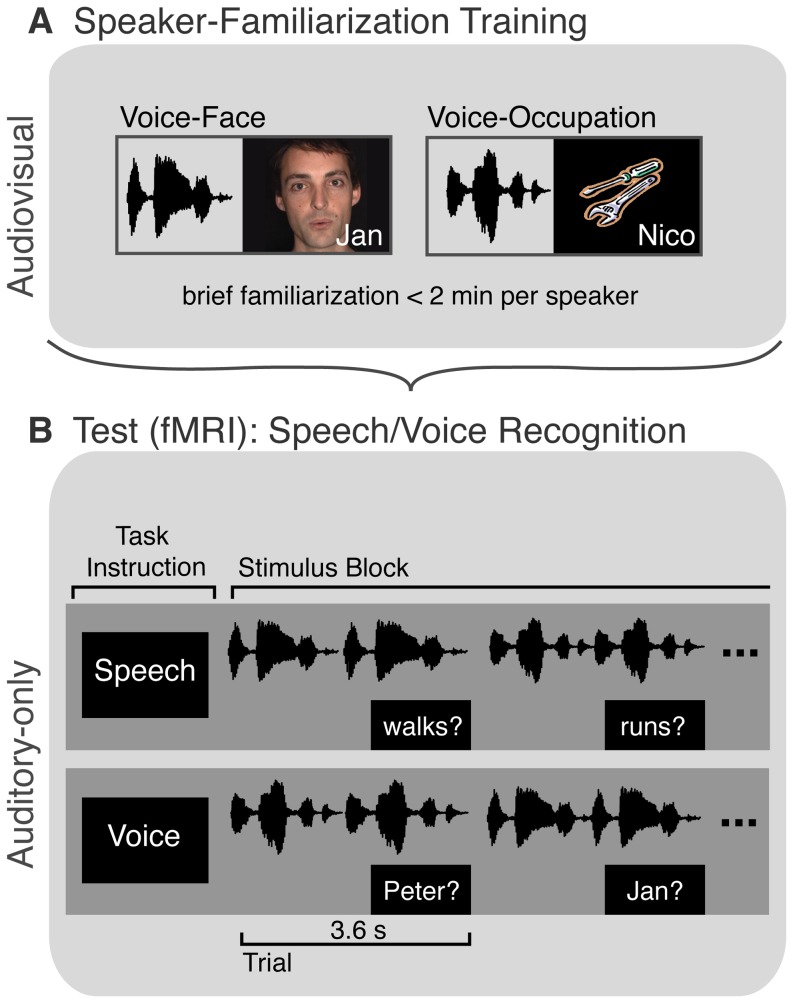
Experimental Paradigm.(A) Prior to fMRI-scanning, participants received audiovisual training to familiarize them with six male speakers. Three speakers were learned by voice, name, and a video showing the speaker’s talking face (voice-face learning), while the other three speakers were learned by voice, name, and a picture illustrating an occupation (voice-occupation learning). (B) FMRI data were acquired in the subsequent auditory-only test-phase. Participants listened to sentences recorded by the six speakers and performed either a speech recognition task (“Did that word occur in the sentence?”) or voice recognition task (“Does the name match the voice identity?”). A written word (speech task) or name (voice task) came on during the last second of the auditory stimulus presentation to prompt the participant to response. Task instructions were given at the beginning of each stimulus block.